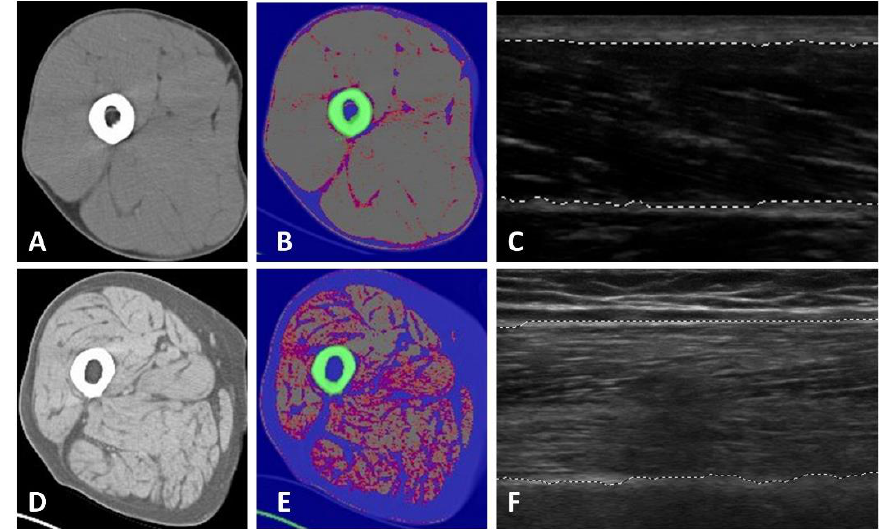
Figure 1. Exemplar ultrasound images of the rectus femoris and axial computed tomography CT images of the mid-thigh in two study participants. Mean grayscale measures of echogenicity at the rectus femoris of the dominant leg were derived from longitudinal ultrasound images and axial CT scans were obtained from the same anatomical plane at the mid-thigh. The images featured in Panel ( A – C ) depict a study participant with 15% cross-sectional fat mass and 7% intra- and intermuscular adipose tissue (IMAT). In contrast, the images in Panel ( D – F ) show a study participant with 66% cross-sectional fat mass and 40% IMAT (Hounsfield units: − 190 to − 30 for adipose tissue, 0 to +30 for low density muscle, and +31 to +100 for normal density muscle tissue).